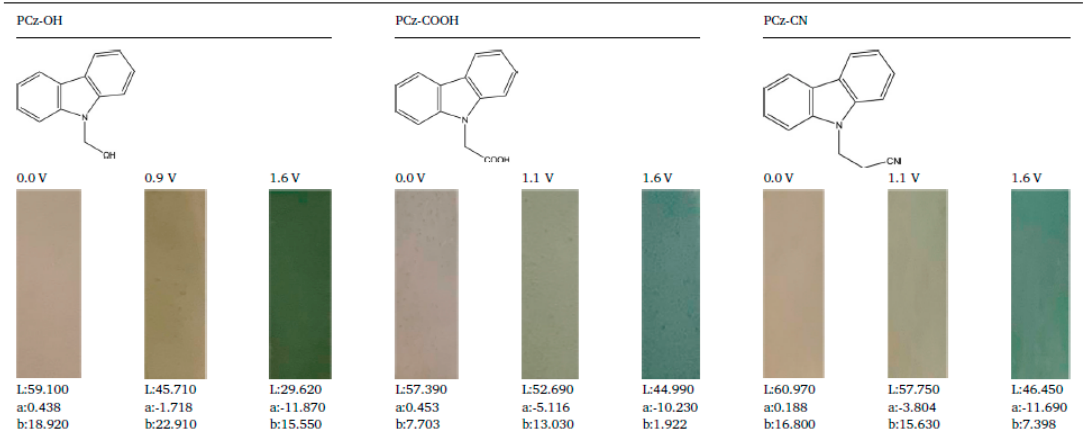
Figure 16. The colour variations induced by redox process on PCz − OH, PCz − COOH and PCz-CN. Reproduced with permission from [146]. Copyright (2020) Elsevier.